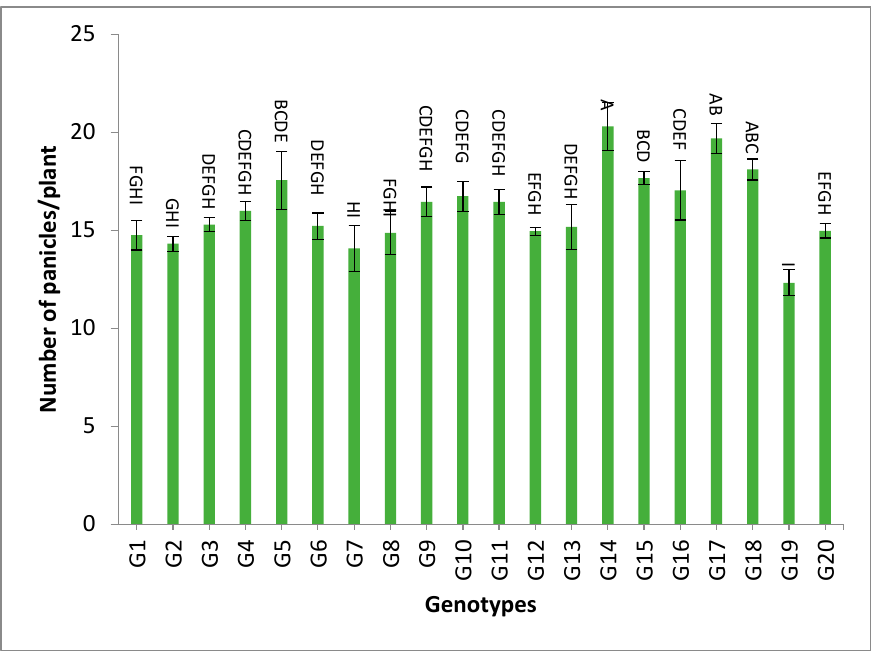
Figure 3. The mean numbers of panicles/plant of twenty rice genotypes over the two years. Bar represents the standard deviation. Different alphabetic letters represent the significant differences among the genotypes at p < 0.05, based on Duncan’s multiple range test.